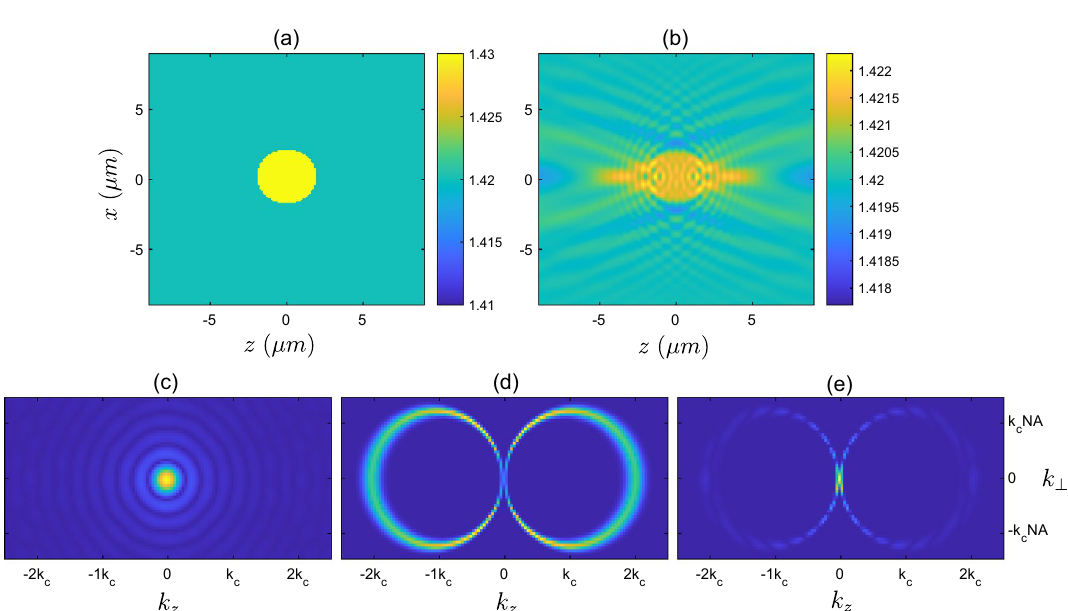
Figure 8. ( a ) Refractive index corresponding to the scattering potential of the low contrast cylinder F 2 . ( b ) Refractive index corresponding to the linear reconstruction F linrec 2 when measuring using all detection directions (with plane wave illumination in the ( k ) F true , of the true low contrast disk sample. ( d ) Theoretical k -space filter for the detection over all angles, 2 | ˜ | ( k ) . ( e ) Magnitude of Fourier transform of true sample after being filtered f � all multiplied by ( d